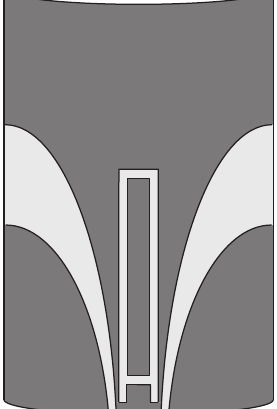
Figure 55: Geometry of the flexible band-notched UWB antenna [65]. The H-shaped slot adopted to realize the band-notched characteristics is indicated. Dark gray metal face and light gray dielectric substrate.